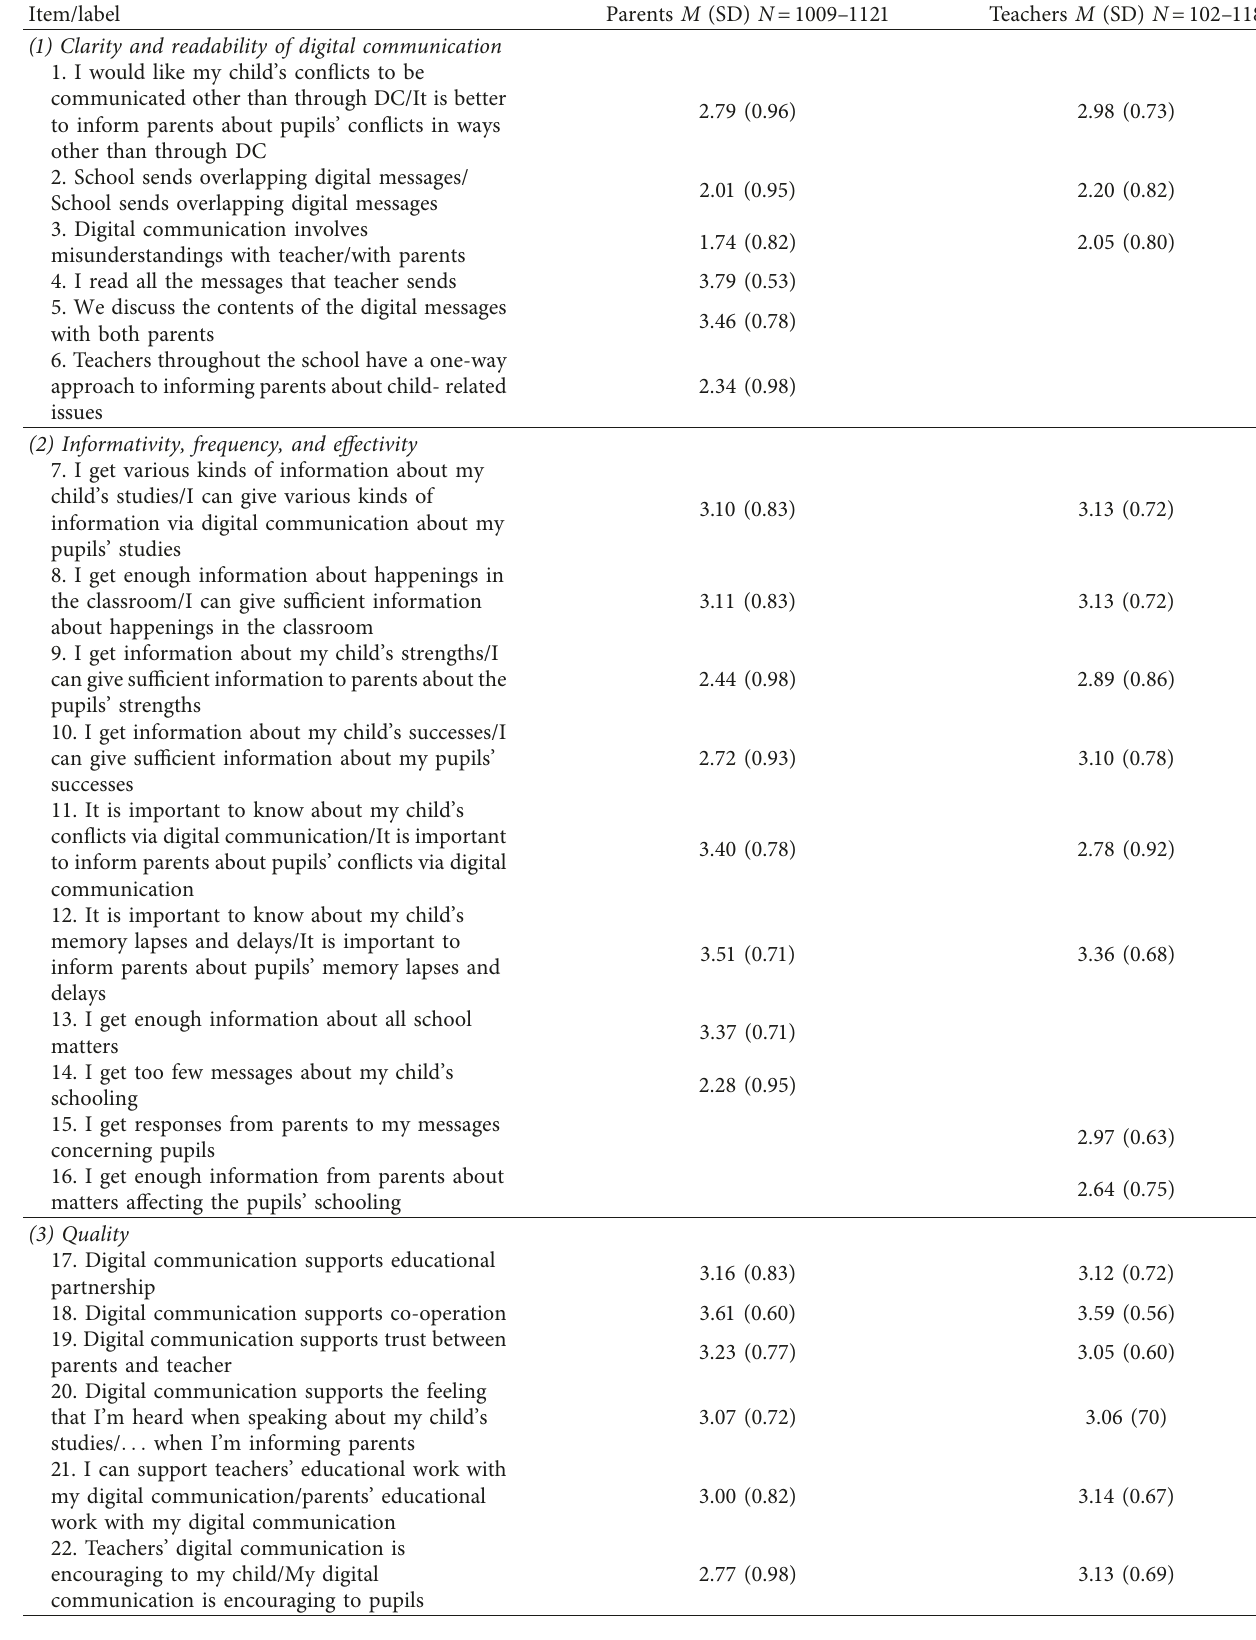
Table 1: The Digital Communication Scale